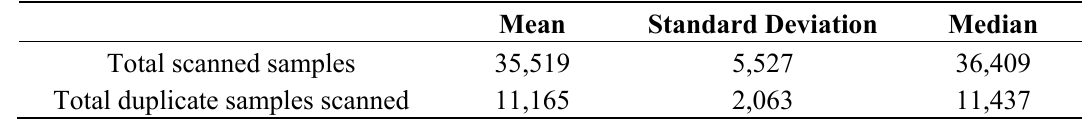
Table 1. Volume of leftover blood samples per month. Leftover blood samples are scanned daily to determine BioVU DNA biobanking eligibility. Samples from subjects who already have DNA samples banked (duplicate samples) are eligible for plasma biobanking. The number of blood samples are represented as the mean, median and standard deviation per month since 2006 through